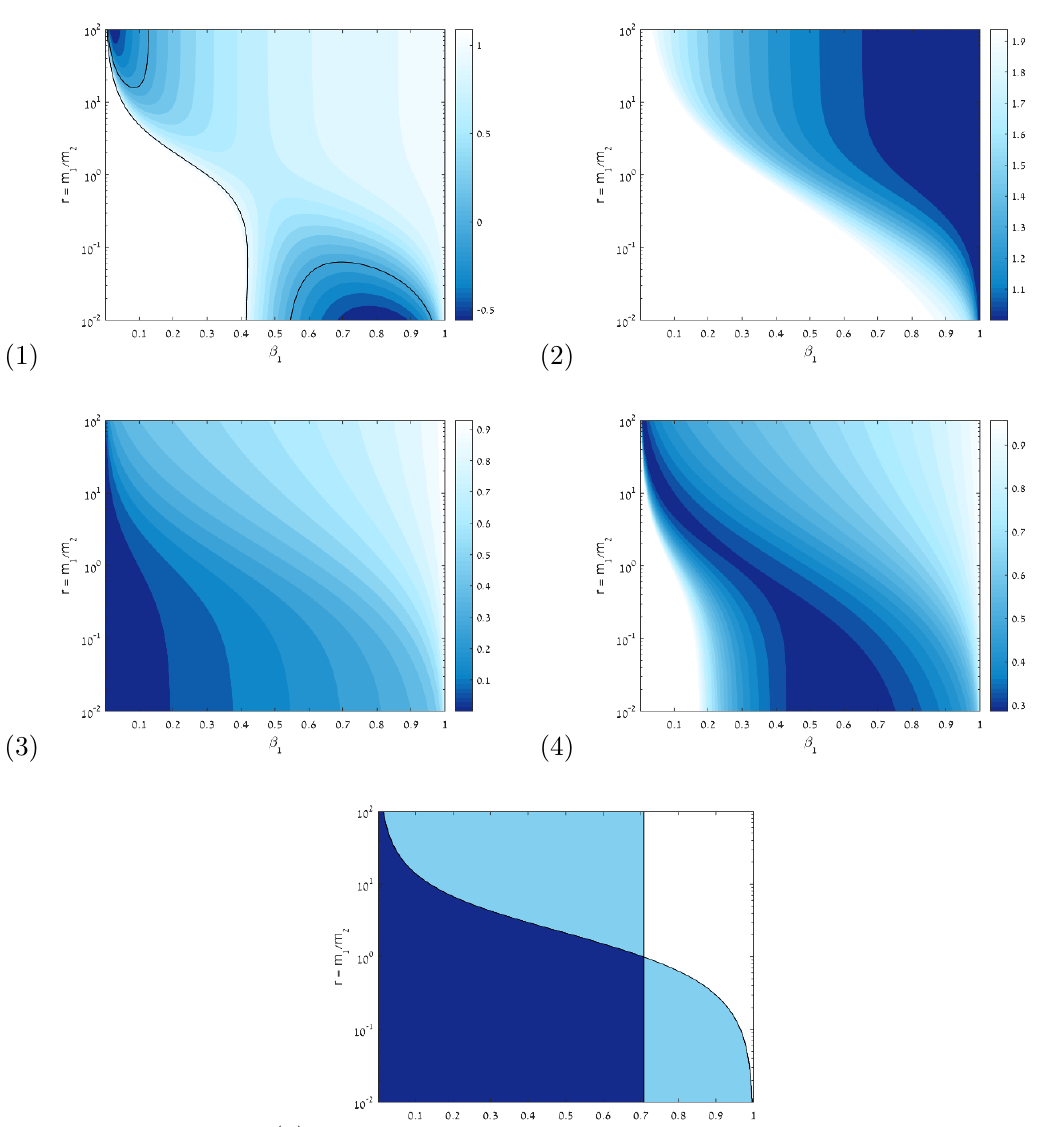
Figure 8 . The intercept as a function of (cid:12) 1 and r = m 1 =m 2 . (1) The transverse intercept (8.9). In this plot the intercept changes sign and along the black line a t = 0. (2) The planar intercept (8.10). (3) The PS intercept (8.11). (4) The full intercept with all three contributions in D = 4. (5) The domain of validity de(cid:12)ned by (cid:12) 1 ; (cid:12) 2 > 1 p (see text). The white area is where both ‘ 1 and ‘ 2 are 2 both (beginning to be) long and the approximation can be trusted. In the light blue area only one of the arms of the string is long, and dark blue means both are short. Note that in (1) and (2) the values in the plot are normalized by dividing by the (cid:12) ! 1 result, so namely, a value of 1 in the plot means the contribution of the mode to the intercept is 1 . In (3) the values should 24 similarly be multiplied by D (cid:0) 26 . The values in (4) are the values of the intercept with no further 24 normalization factors.